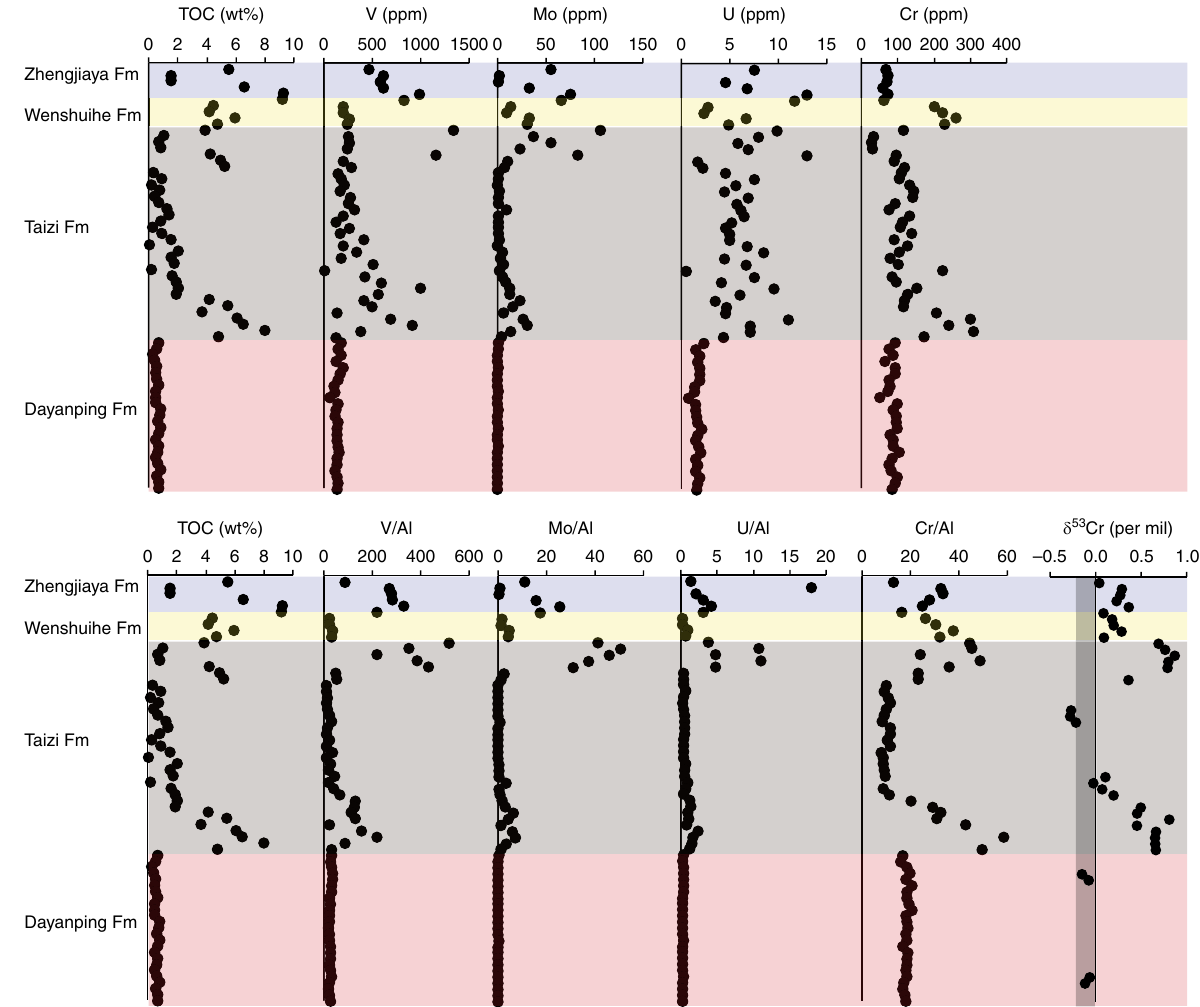
Fig. 3 Geochemical data from the Shennongjia Group. Samples are plotted sequentially and relative to stratigraphic position (from top to bottom), but not as function of exact stratigraphic position, but rather by sample number (1, 2, 3, etc.). Therefore, the depth trends in the fi gure and do not re fl ect actual placement in the stratigraphy (see Fig. 1). The gray vertical bar in the δ 53 Cr plot represents the crustal average value